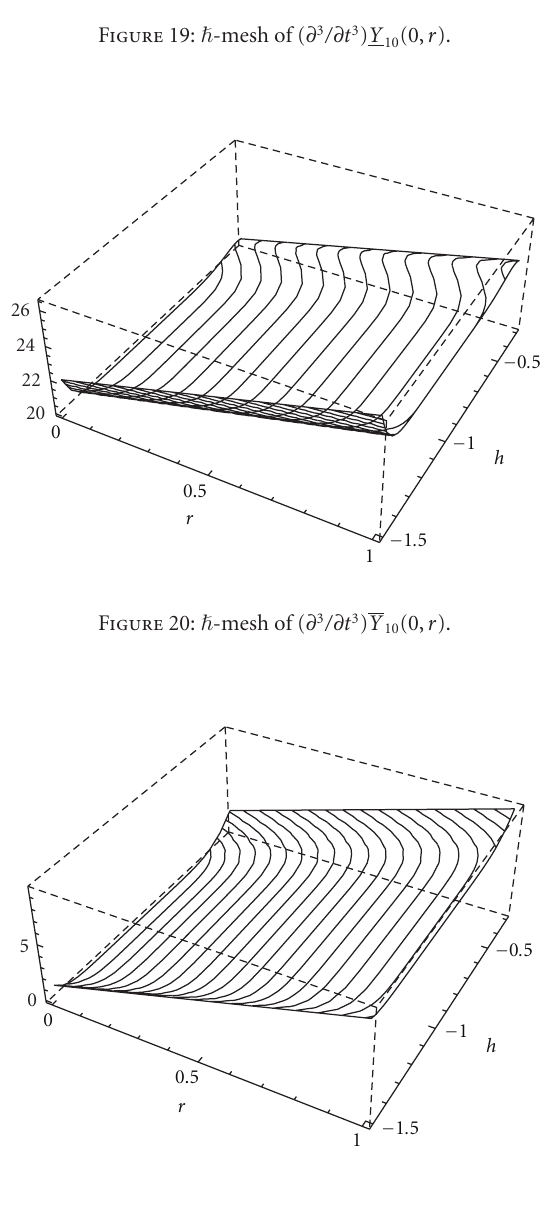
Figure 21: (cid:2) -mesh of ( ∂ 3 /∂t 3 ) G